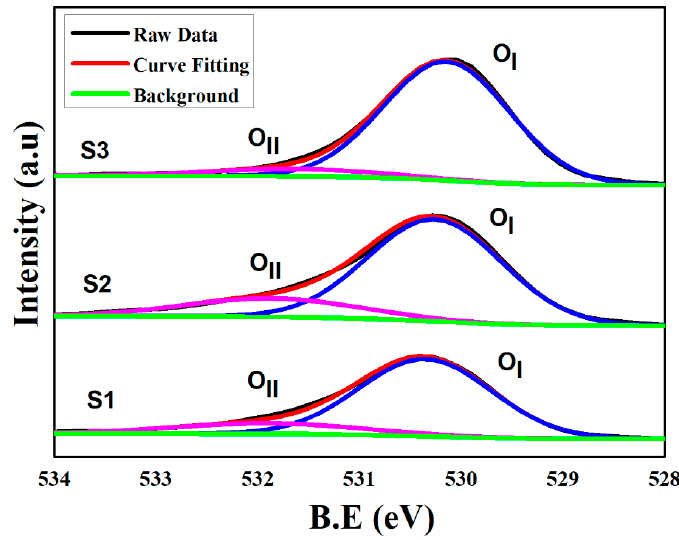
Figure 6. XPS analysis of S1, S2, and S3.